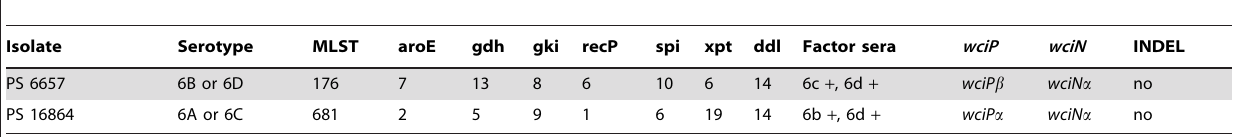
Table 3. Characteristic of two serogroup 6 isolates which could not be unambiguously assigned to any of the four serotypes.